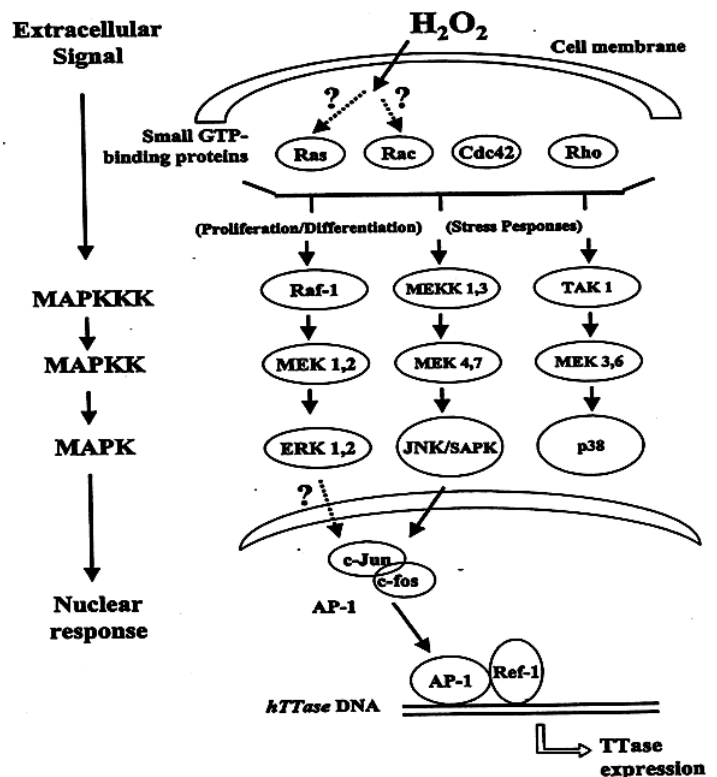
Figure 7. Possible mechanism for redox signaling-induced TTase expression. Ras, Rac, Cdc42, Rho are small GTP-binding proteins; MAPK: mitogen activated protein kinase; MAPKK: MARK kinase; MAPKKK: MAPKK kinase; Raf-1-MEK 1,2-ERK1,2 represents the mitogenic pathway; MEKK 1,3-MEK 4,7-JNK/SAPK represents stress/mitogenic-pathway; TAK 1-MEK 3,6-p38 represents stress-associated pathway; AP-1 represents the transcription factor consists of c-Jun and c-fos heterodimer; ref-1 represents the redox sensor for AP-1; httase : human thioltransferase gene and TTase: thioltransferase. Reprinted with permission from Lou, PRER (2003); Copyright Elsevier 2003 [8].